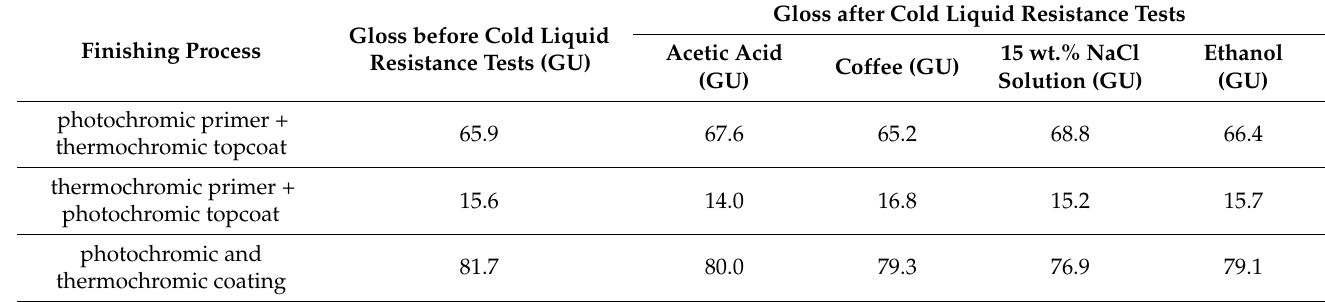
Table 7. Gloss of the film before and after cold liquid resistance tests under different finishing sequences.